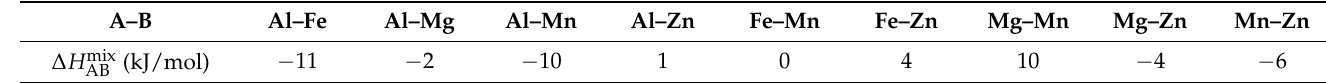
Table 2. The values of the heat of formation ( ∆ H mix